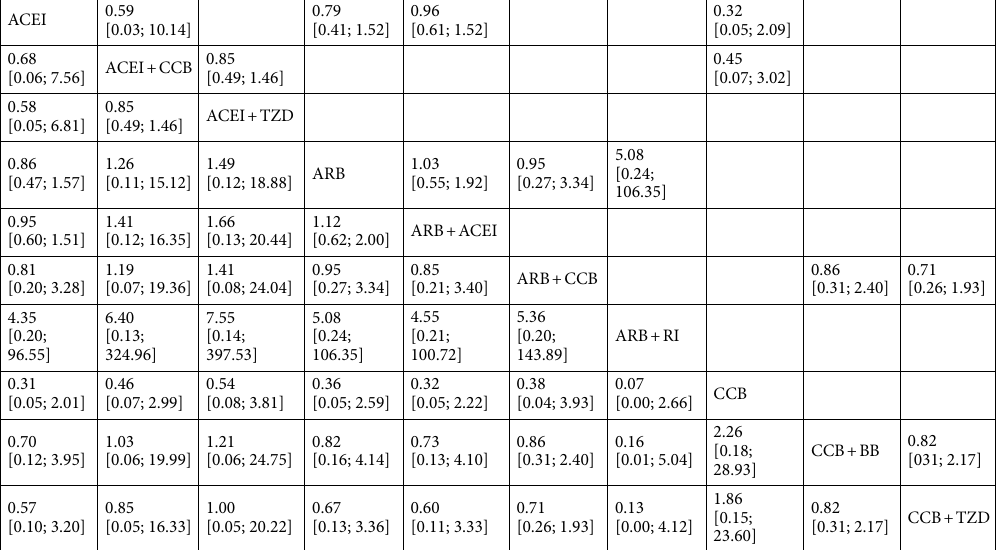
Table 7. Net league table of all-cause mortality. ACEI, angiotensin converting enzyme inhibitors; ARB, angiotensin receptor blockers; BB, beta-blocker; CCB, calcium channel blockers; RI, renin inhibitor; TZD, thiazide